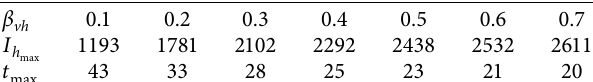
Table 3: Influence of the vector-to-host transmission rate β the maximum proportion of infected individuals in the host population I h at time t . max max